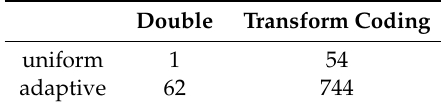
Figure 10. Left: highly local peak function. Right: adaptively refined mesh with 4237 vertices for minimal finite element interpolation error. A uniform grid with the same local resolution has 263,169 vertices. Table 1. Compression factors for adaptive mesh refinement and transform coding of the peak function shown in Figure 10. Adaptive and uniform mesh refinement yield the same interpolation error; the same error tolerance for lossy compression was used in the two